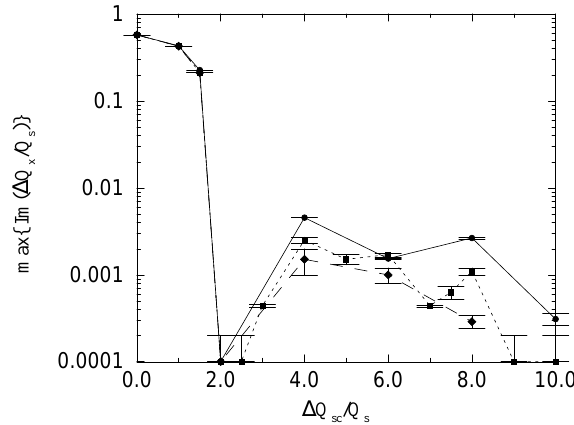
FIG. 8. Largest value of Im (cid:115) D (cid:81) (cid:120) (cid:121) (cid:81) (cid:115) (cid:100) vs D (cid:81) (cid:115)(cid:99) (cid:121) (cid:81) (cid:115) with (cid:76) (cid:173) m (cid:173) (cid:49) for various values of (cid:110) (cid:44) and t (cid:101) : (cid:110) (cid:44) (cid:173) (cid:50)(cid:53) , t (cid:101) (cid:173) (cid:48)(cid:46)(cid:48)(cid:53) , circles, solid line; (cid:110) (cid:44) (cid:173) (cid:53)(cid:48) , t (cid:101) (cid:173) (cid:48)(cid:46)(cid:48)(cid:50) , squares, short dashed line; (cid:110) (cid:44) (cid:173) (cid:49)(cid:48)(cid:48) , t (cid:101) (cid:173) (cid:48)(cid:46)(cid:48)(cid:49) , diamonds, long dashed line. The value of the step function wake was 2.5 times larger than the threshold value with D (cid:81) (cid:115)(cid:99) (cid:173) (cid:48) .